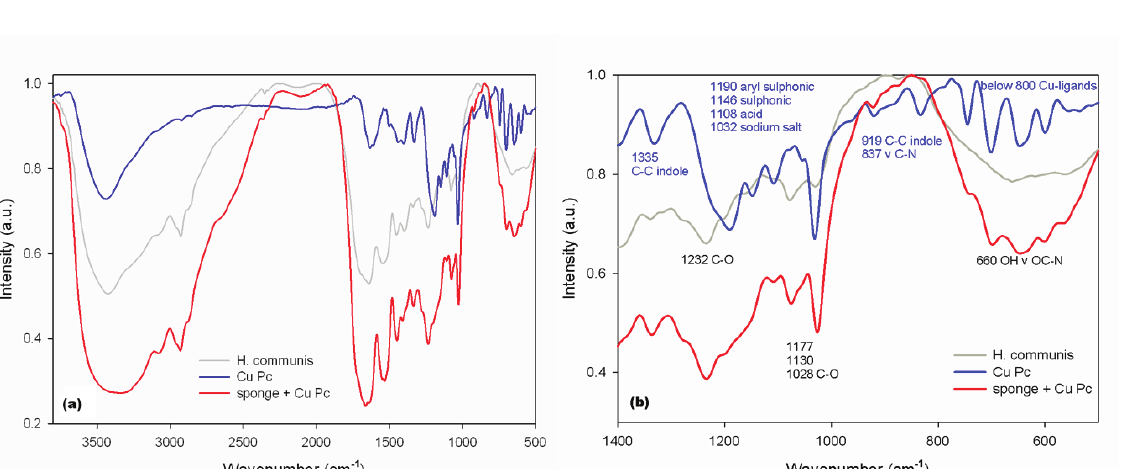
Figure 4: FTIR spectra of the purified H. communis skeleton, CuPC and dye adsorbed onto sponge skeleton (pH=2, 120 min, 400 mg/L), in different wavenumber ranges.